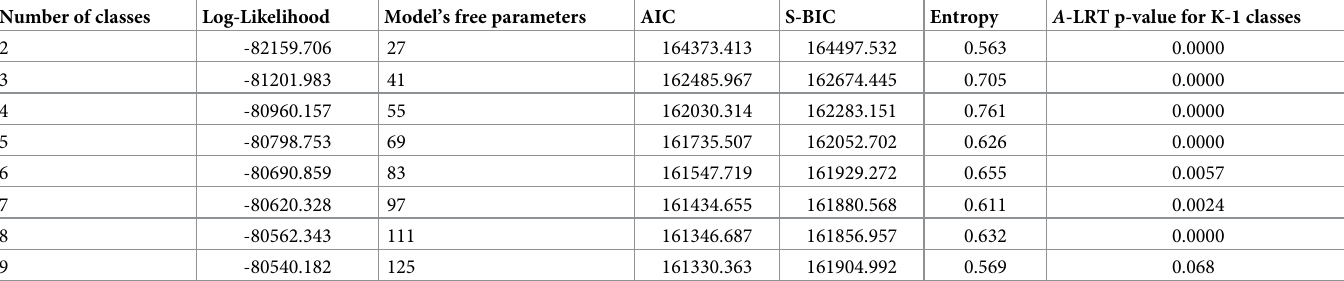
Table 2. Selection of number of classes for the parents’ generation (G1). Indicators of Model Fit. Number of classes